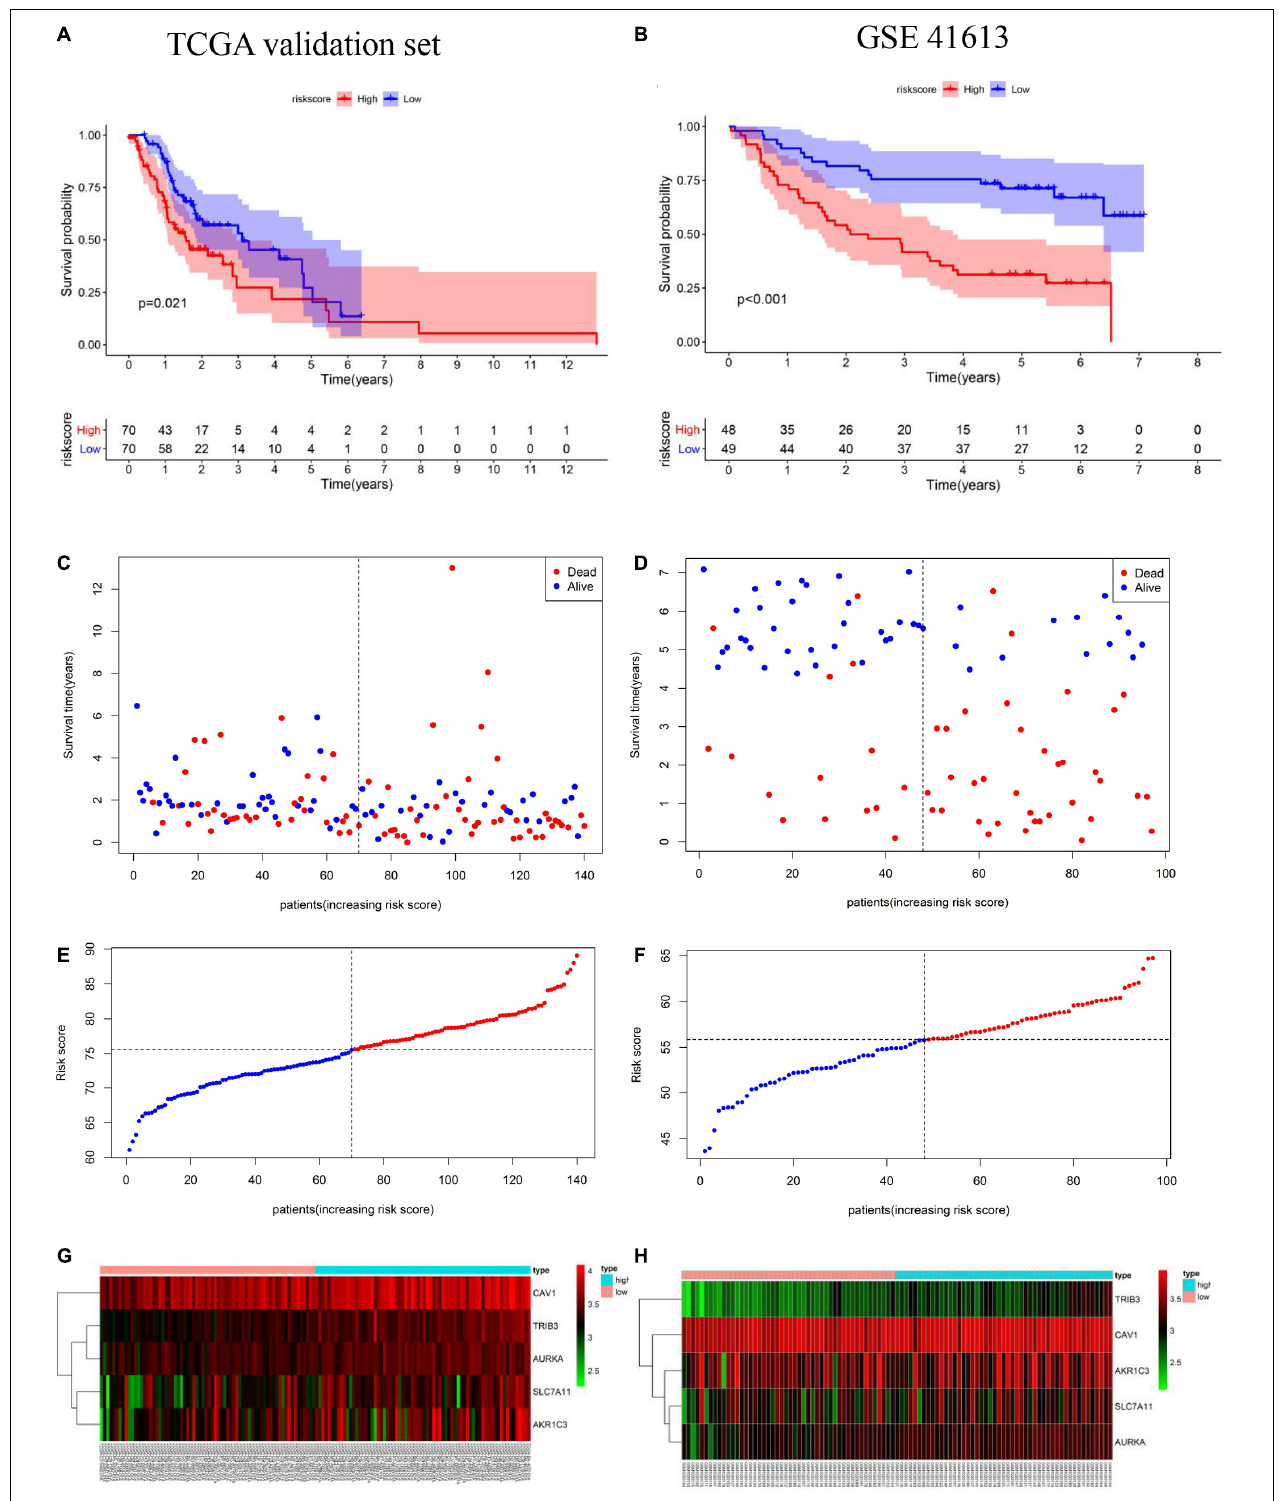
FIGURE 4 | Validation of the prognostic model including ferroptosis-related genes (FRGs) using the cancer genome atlas (TCGA) validation set based on the five gene signature risk scores. (A,B) Kaplan-Meier curves for the overall survival of high- and low-risk patients in the TCGA validation set and Gene Expression Omnibus (GEO) validation set. (C,D) Relationships between the expression levels of prognostic FRGs and the risk groups. (E,F) Distribution of the risk score and the median risk score in the TCGA and GEO cohorts. (G,H) Relationship between the expression levels of prognostic FRGs in the different risk groups.